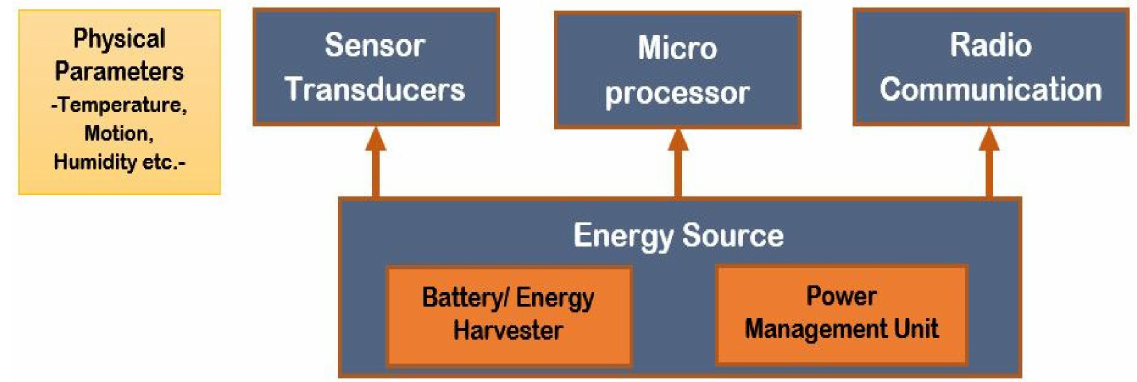
Figure 5. Block diagram of a typical WSAN node for livestock